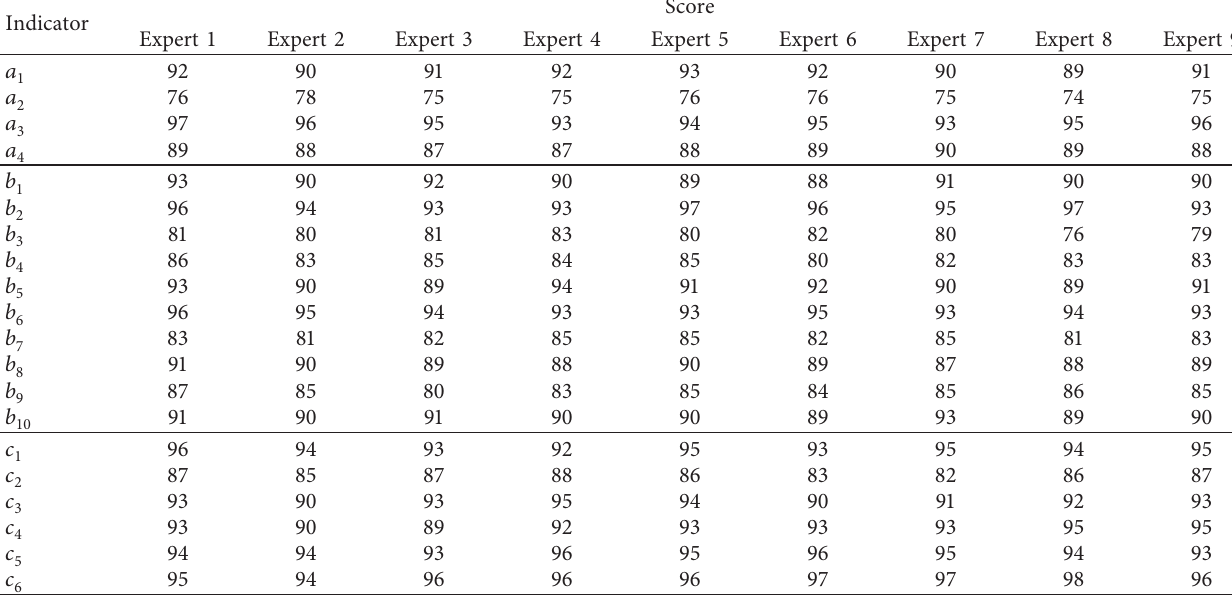
Table 8: Indicator scoring results of section 8.